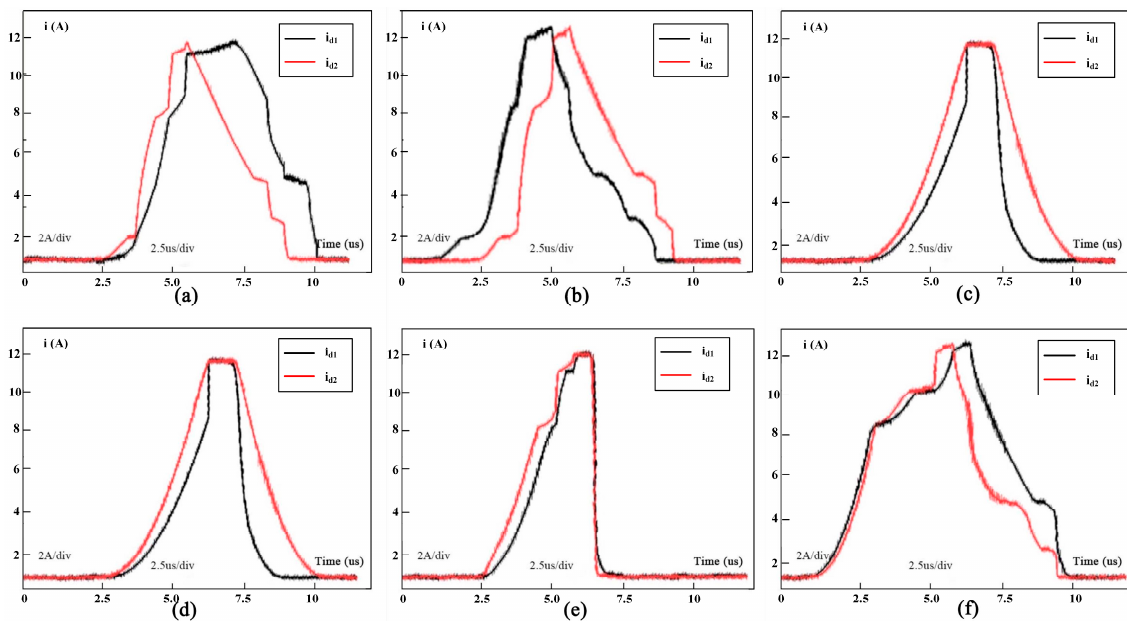
Figure 20. Parallel current imbalance suppression waveform of magnetic ferrite inductance combined with a gate drive circuit on parasitic parameters: ( a ) suppression waveform of L g ; ( b ) suppression waveform of L d ; ( c ) suppression waveform of L s ; ( d ) suppression waveform of C gs ; € suppression waveform of C gd ; and ( f ) suppression waveform of C ds .